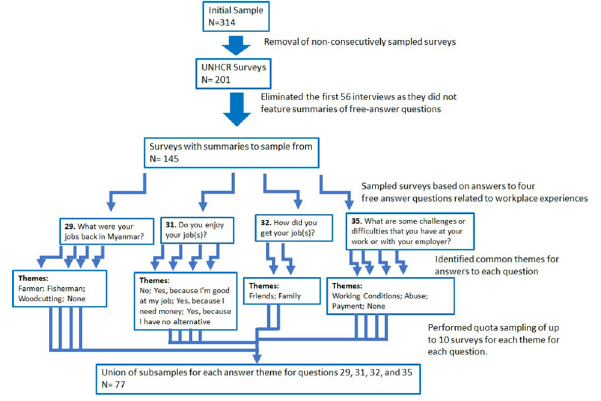
Fig. 9 Sampling framework for interviews chosen for thematic analysis. Sampling framework and fi ndings of thematic